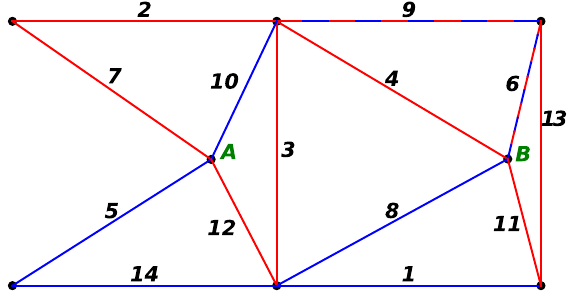
Figure 13. Generated truss under multiple load cases I and II, weight = 2257.40 kg, color red and blue